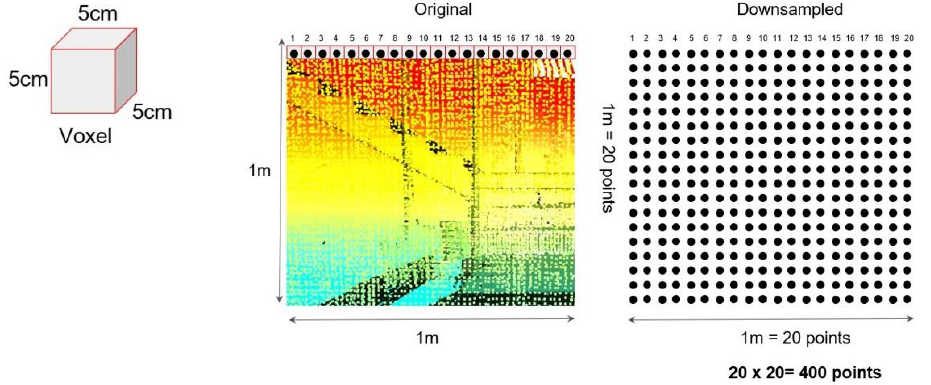
Figure 8. Points per face area.